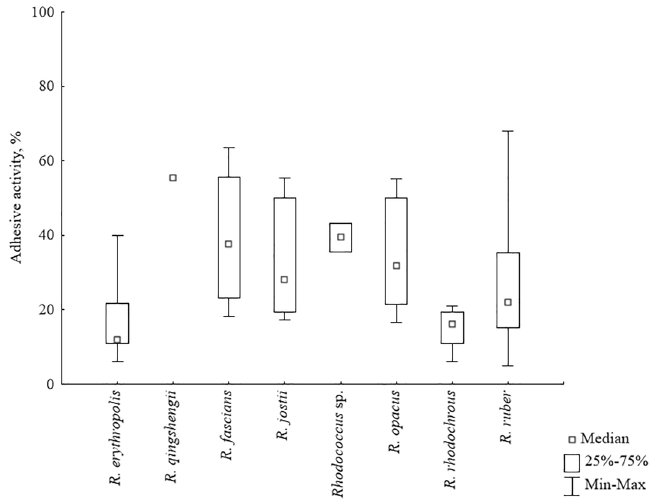
Figure 1. Adhesive activities of Rhodococcus strains towards the reference solid surface (polystyrene) depending on the